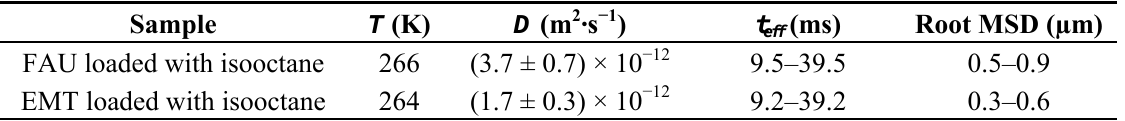
Table 4. Intracrystalline diffusivities of isooctane in the FAU and EMT zeolites. The diffusivities were obtained for the shown range of the effective diffusion times and the corresponding values of the root MSD by fitting the measured PFG NMR attenuation curves using Equation (1) with n =